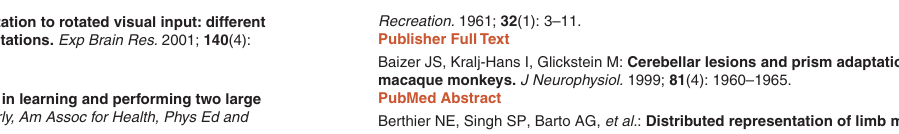
figshare : Data from motor learning experiments, doi: 10.6084/ m9.figshare.957526 (Chu & Sanger,